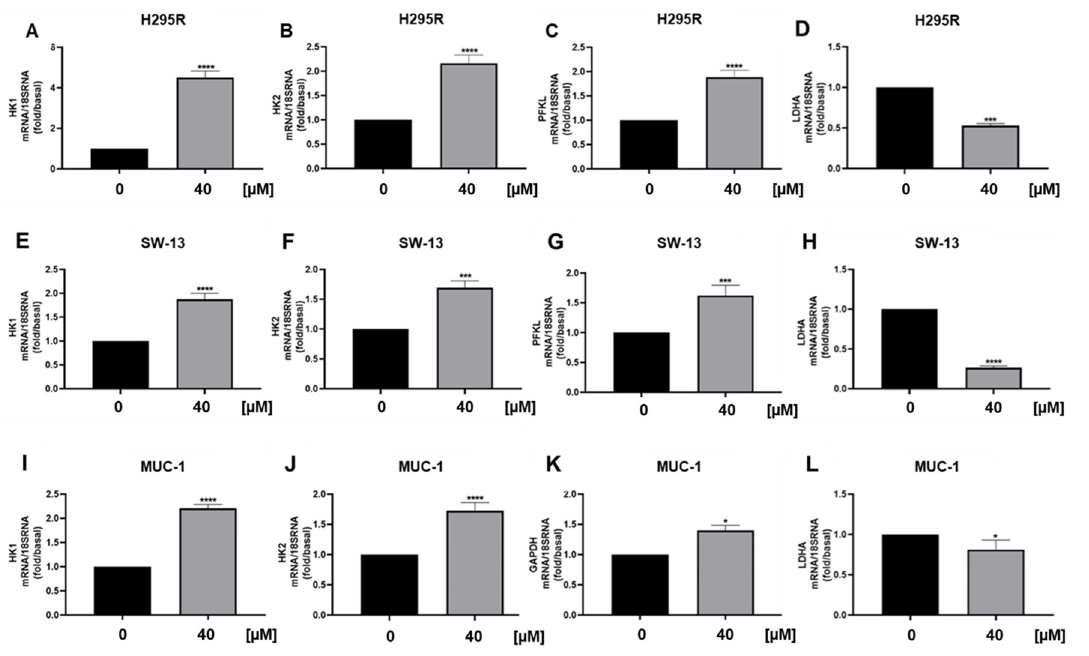
curcumin inhibitory effects [Figure 11E].